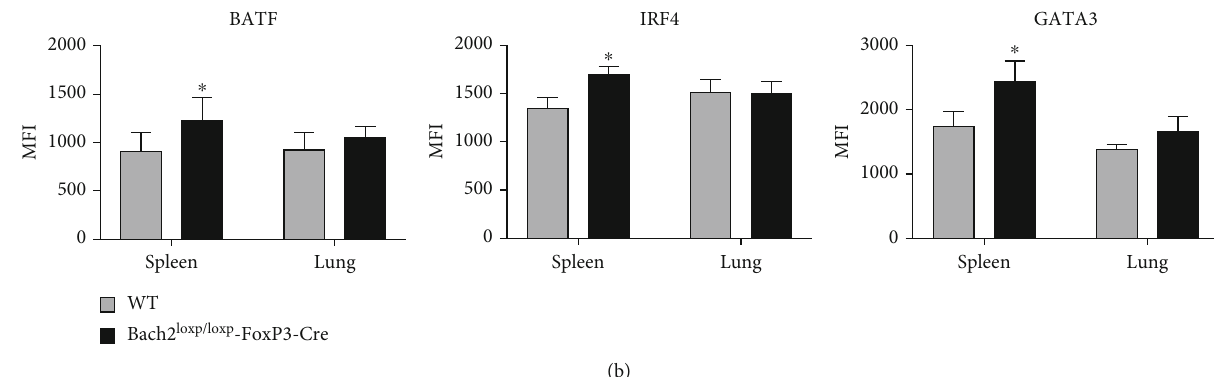
Figure 2: Bach2 restrains tissue regulatory T cell di ff erentiation in the spleen. Spleens and lungs were collected from naïve WT and Bach2 loxp/loxp FoxP3-Cre mice and Tregs were analyzed by fl ow cytometry. (a) Frequency and number of Foxp3 +ve Tregs in lung and splenic Treg cells that expressed CXCR3, CD103, or ST2. (b) Data shows MFI levels for BATF, IRF4, and GATA3 staining in Foxp3 +ve Tregs. This experiment was repeated three times with similar results, 4-5 mice per group. ∗ p < 0 : 05